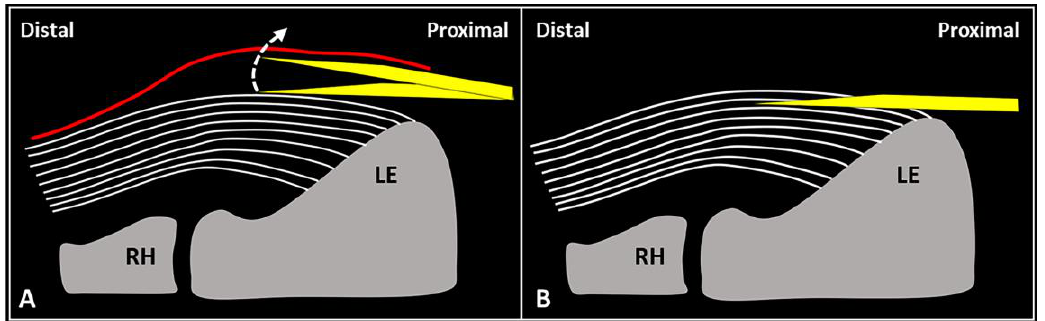
Figure 2. When the needle’s tip ( yellow ) is correctly positioned just over the superficial edge of the CET, by gently tilting ( curved dotted arrow ) the needle, it is possible to “separate” the forearm fascia ( red ) from the underlying tendon without hard resistance ( A ). Conversely, if the needle’s tip ( yellow ) is located inside the superficial portion of the CET, a “block” can be felt during this maneuver due to the intratendinous entrapment of the needle between the tendon fibers ( white lines ) ( B ). RH: radial head, LE: lateral epicondyle.